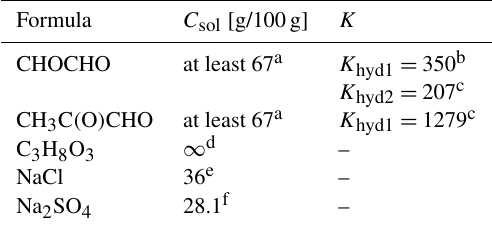
Figure 1. Formation of mono- and dihydrated glyoxal (first row) and methylglyoxal (second row). The values of equilibrium con- stants, K hyd1 and K hyd2 , are shown in Table 1. Table 1. Properties of the studied organic and inorganic compounds, including organic hydrates: molecular formula, aqueous solubility ( C sol [g/100g]) at 25 ◦ C and equilibrium constant ( K ) for each hy- dration step. To the best of our knowledge, the equilibrium constant for the second hydration step of methylglyoxal, K hyd2 , is not avail- able in the